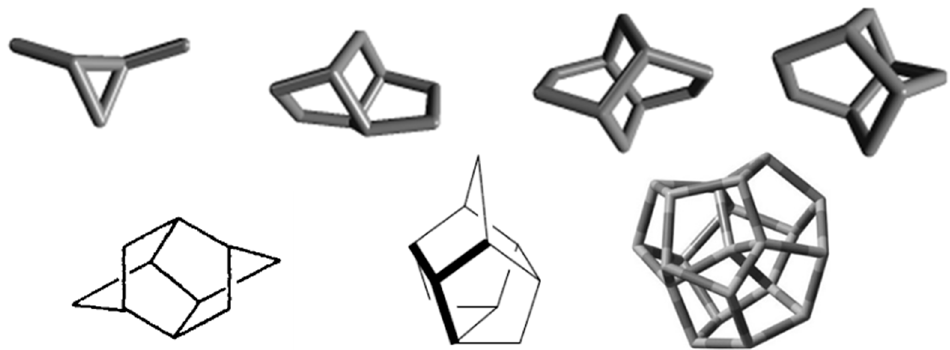
Figure 2. The seven molecules considered: dimethylcyclopropane, brexane, twistane, twistbren- dane, ditwistbrendane, trishomocubane and chiralane. ditwistbrendane, trishomocubane and